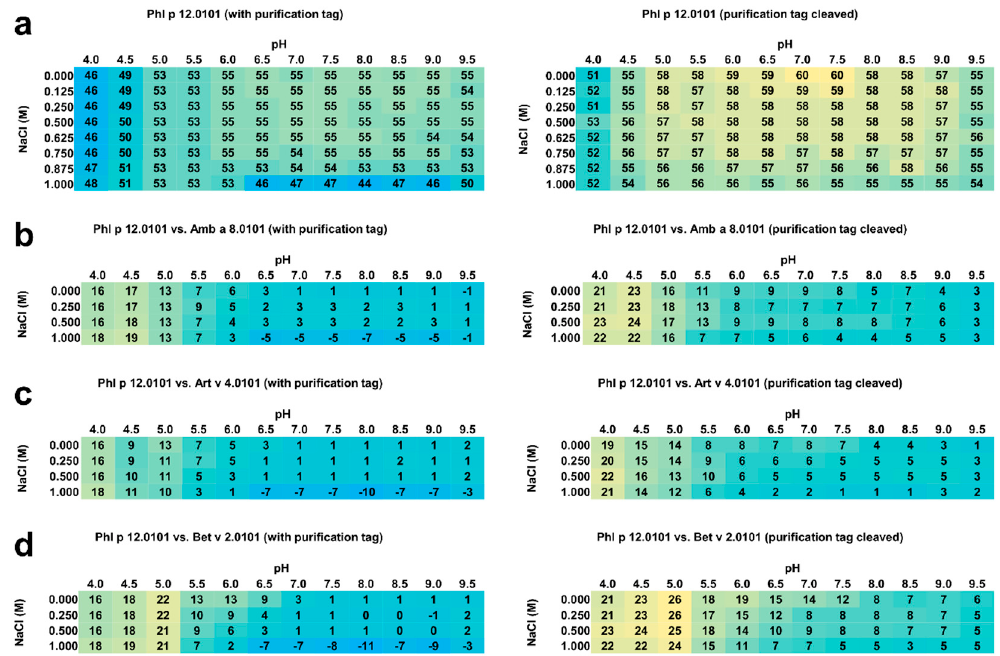
Figure 3. ( a ) Average melting temperatures (T m in ◦ C) for rPhl p 12.0101 with and without purification tag. Yellowandbluerepresenthighandlowmeltingtemperatures, respectively. ( b )Meltingtemperature (T m in ◦ C) di ff erences between rPhl p 12.0101 and rAmb a 8.0101. ( c ) Melting temperature di ff erences between rPhl p 12.0101 and rArt v 4.0101. ( d ) Melting temperature di ff erences between rPhl p 12.0101 and rBet v 2.0101. Yellow and blue represent high and low di ff erences in the melting temperatures, respectively. The standard deviation for the presented values was less than 1 ◦ C for all